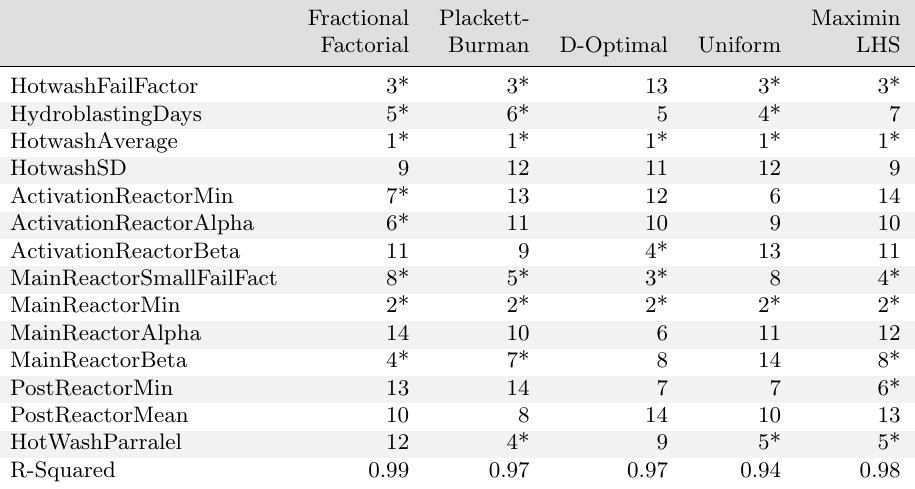
Table 2: Summarised results from the screening